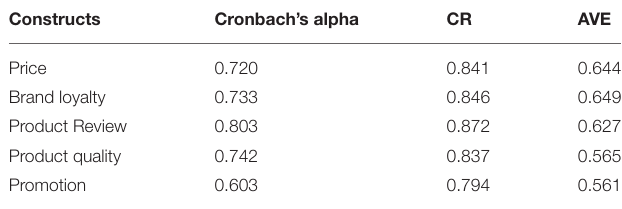
TABLE 2 | Validity and reliability for constructs.